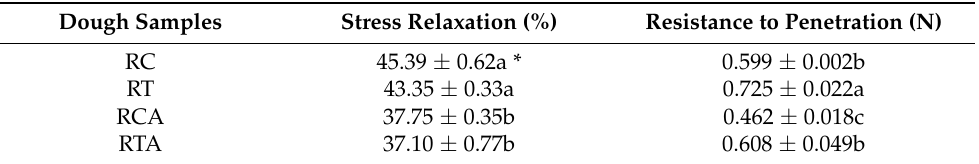
Table 3. Mean values and standard deviations of dough texture parameters obtained through the application of the stress-relaxation and penetration tests.